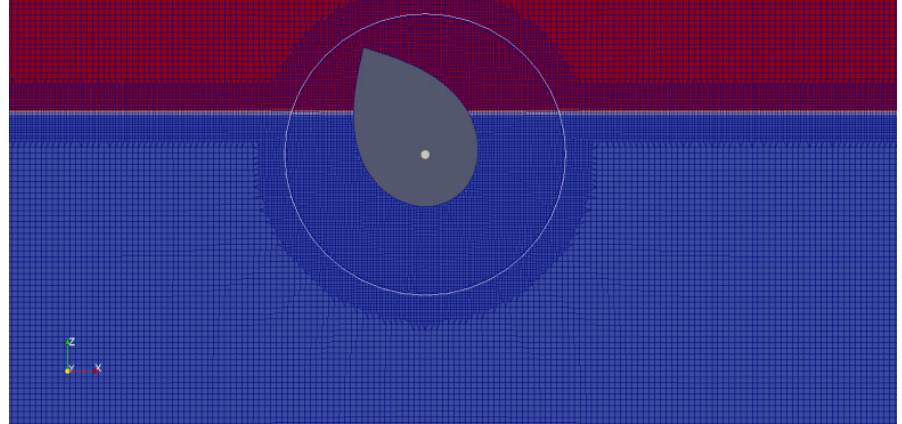
Figure 4. Two-dimensional grid system near WEC and free surface elevation.